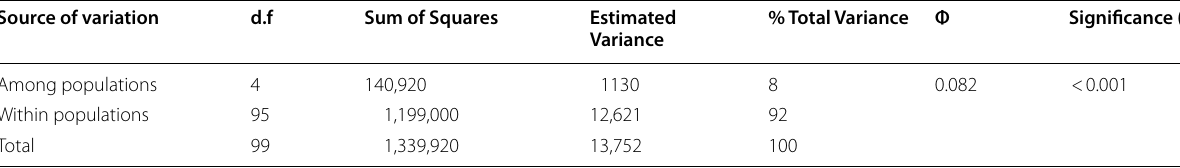
Table 7 Summary of the analysis of molecular variance (AMOVA) in giant plantain using GenAlEx